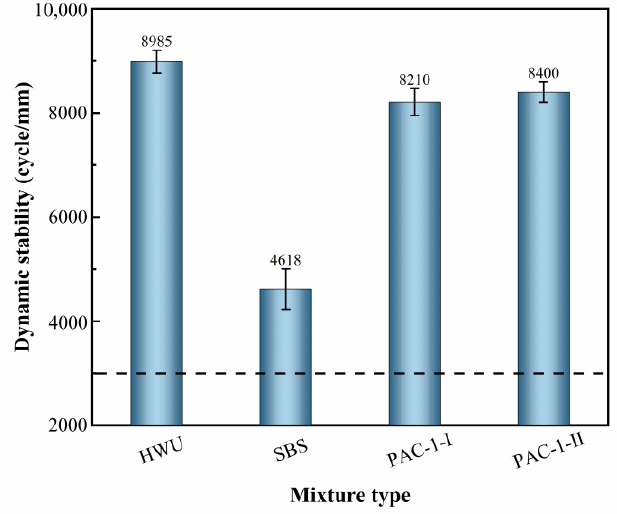
Figure 7. Rutting test results of the